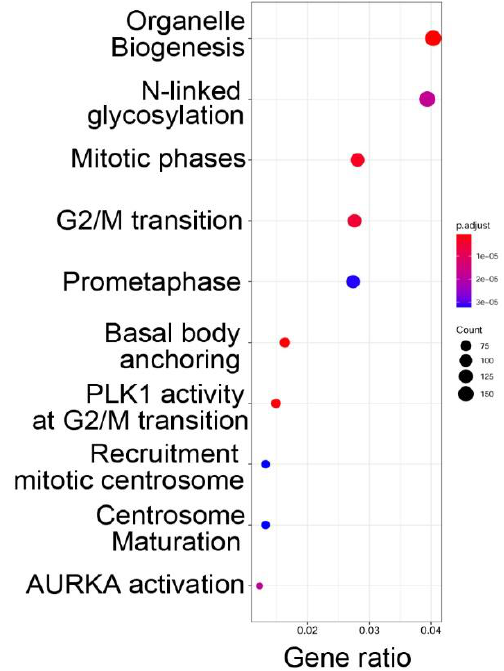
Figure 3. Gene pathways associated with open chromatin domains in hSAECs. Shown are genome ontologies ranked by the number of genes in a pathway (gene ratio) and by enrichment relative to genome (adjusted p value, padjust). N, NH2 terminal; G2 / M, cell cycle phases; PLK1 Polo Like Kinase 1, AURKA, Aurora Kinase A.